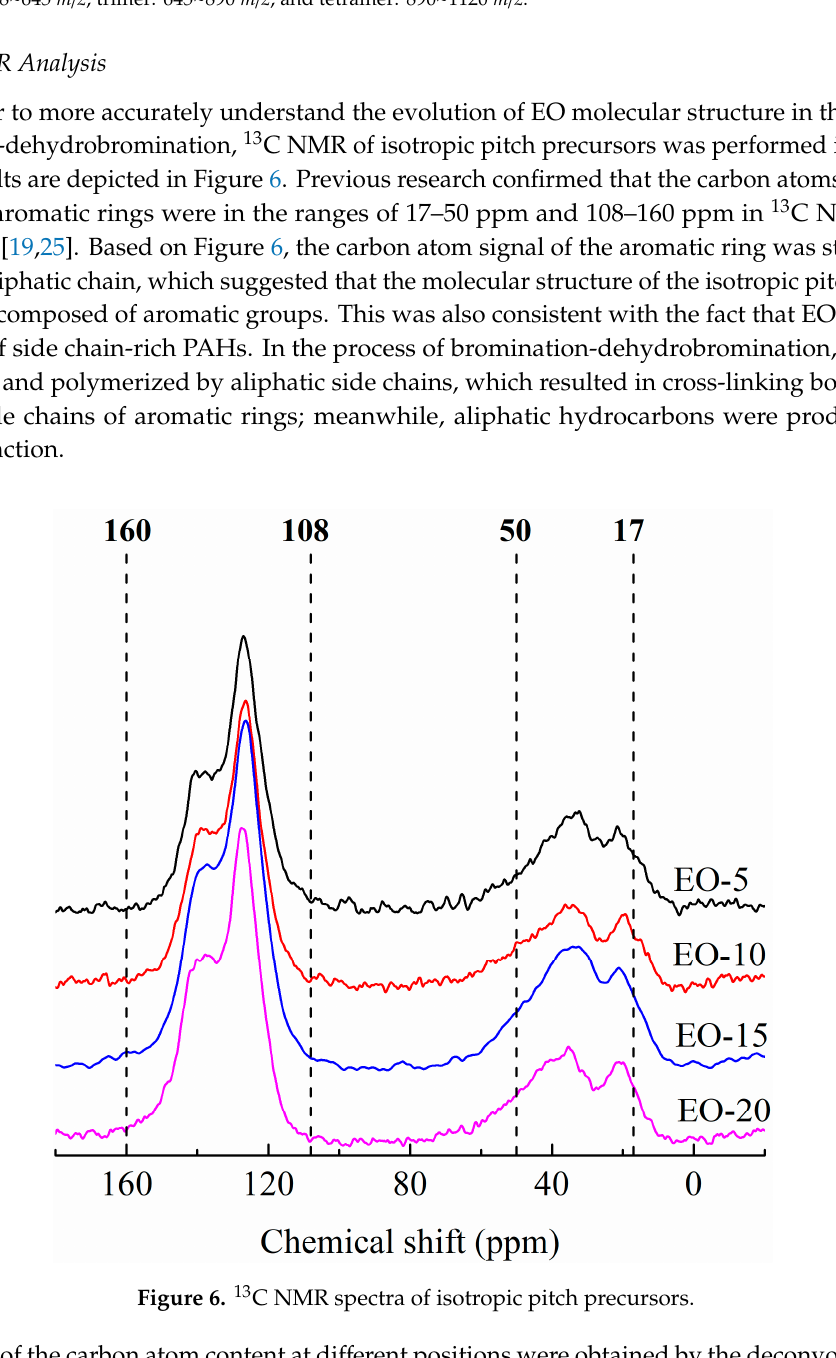
Table 2. The average molecular weight and molecular compositions of isotropic pitch precursors.